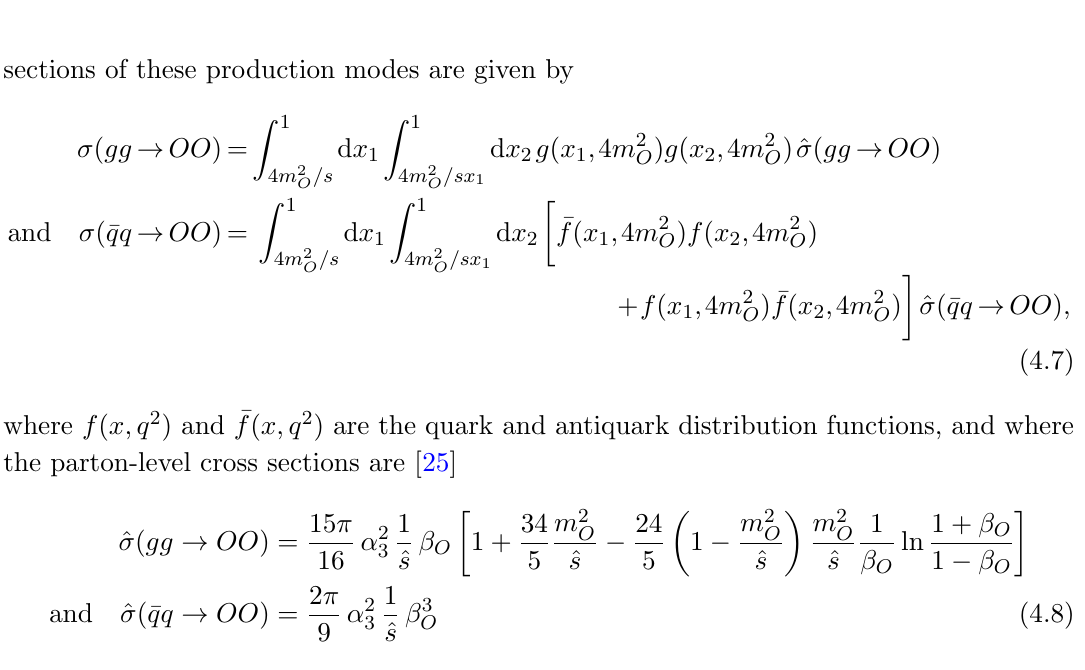
Figure 4. Diagrams for scalar sgluon pair production due to (a) gluon fusion and (b) quark- antiquark annihilation. The diagrams for pseudoscalar pair production are given by replacing O ! o